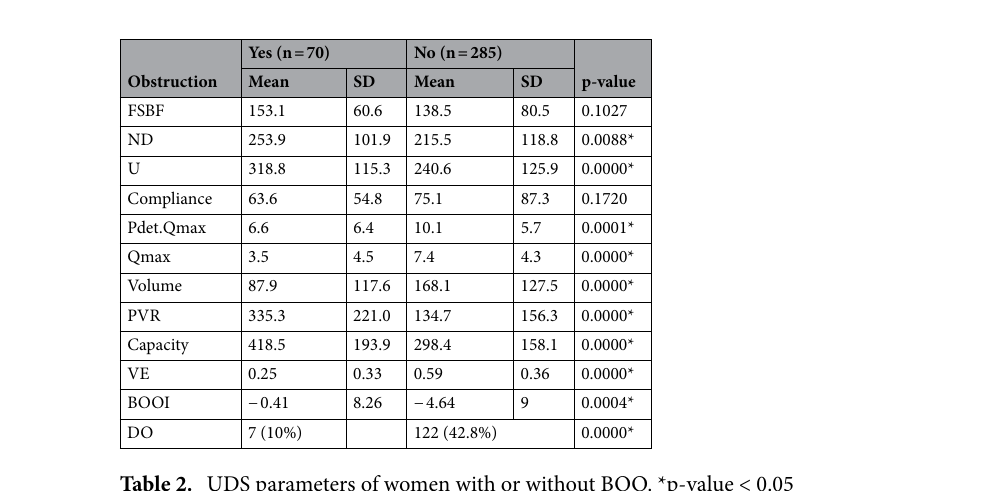
Table 2. UDS parameters of women with or without BOO. *p-value < 0.05